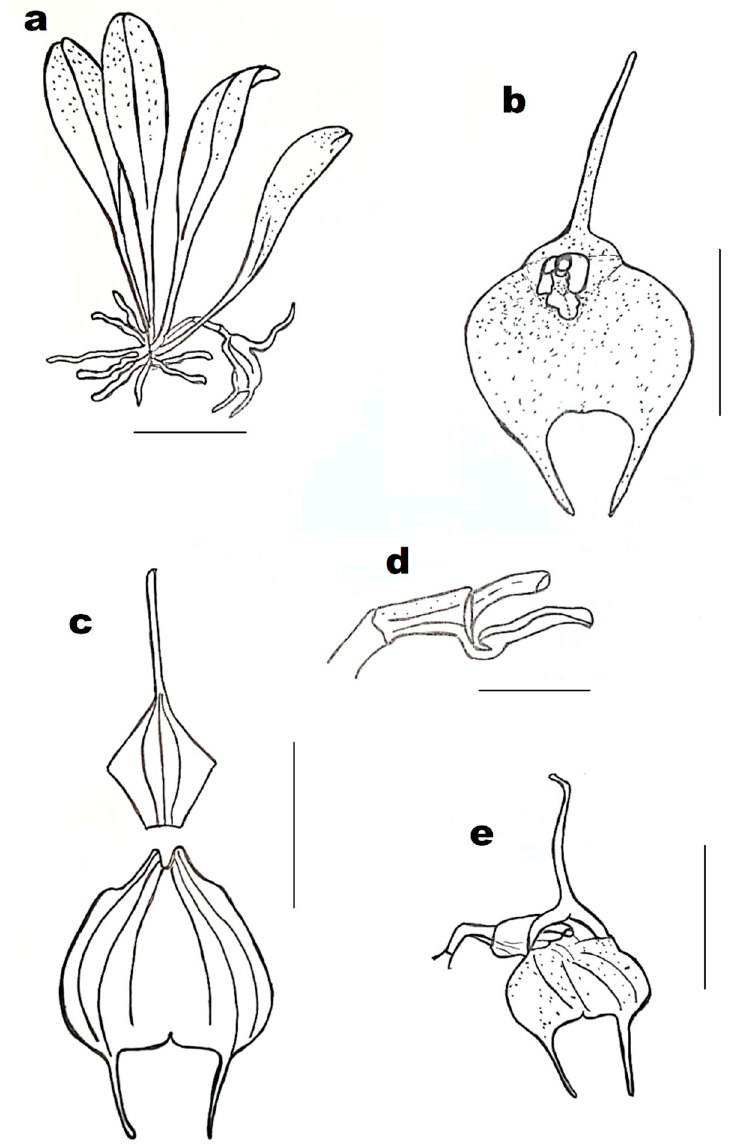
Figure 3. Masdevallia tuerckheimii : ( a ) habit; ( b ) front view of the flower; ( c ) perianth parts; ( d ) side view on column and lip; ( e ) side view of the flower (redrawn by Lipi´nska, scale bars: ( a ) 3 cm; ( b , d ) 1 cm; ( e ) 1 cm).